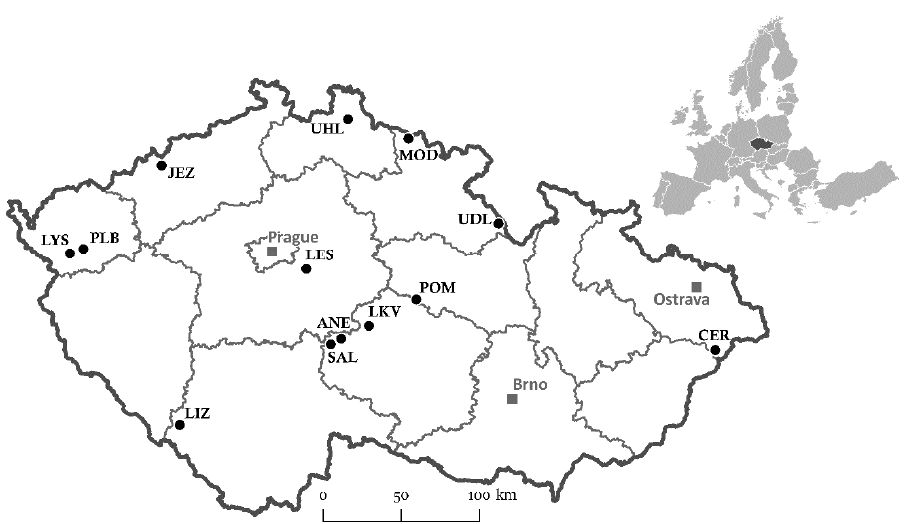
Figure 1. Locations of stream catchments within the GEOMON monitoring network in the Czech